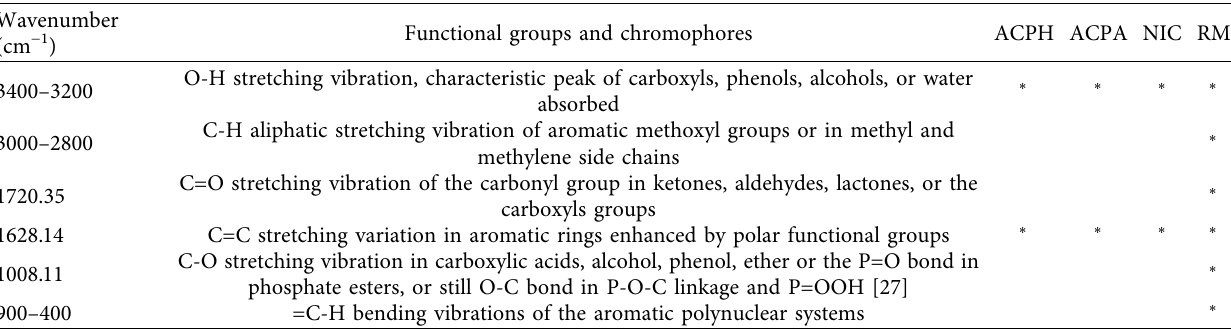
Figure 5: FT-IR spectra of the peelings of cassava tubers and their activated carbon. Table 4: Wavenumbers and attributions of the principal bands in the FTIR spectra of peelings of cassava tubers and activated carbons (ACPH, ACPA, NIC, and